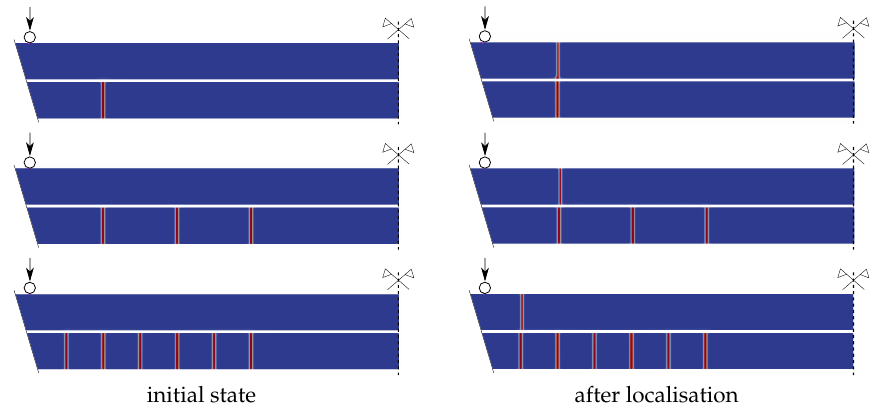
Figure 18. Phase-field variable in pre-cracked laminated glass under four-point bending with a different number of initial cracks in a symmetric half of the sample. Initial crack pattern in bottom glass ply and the final fracture for the EVA-based samples for PF-P formulation, anisotropic staggered approach with the spectral-decomposition split, PS